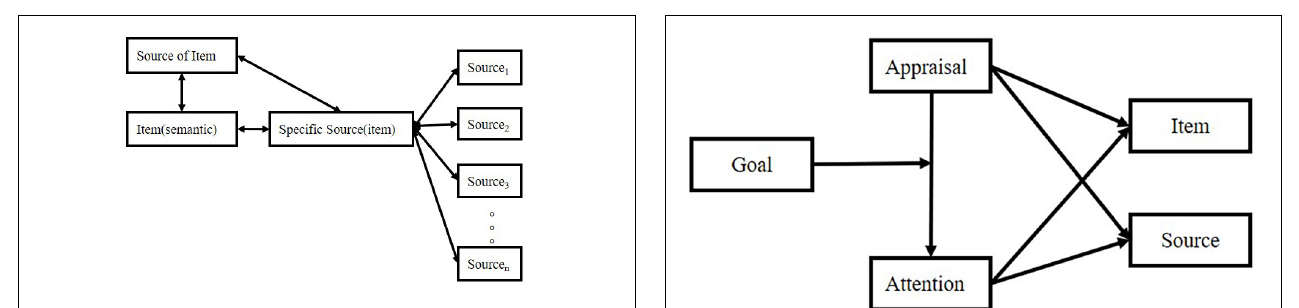
FIGURE 5 | Retrieval of source memory.